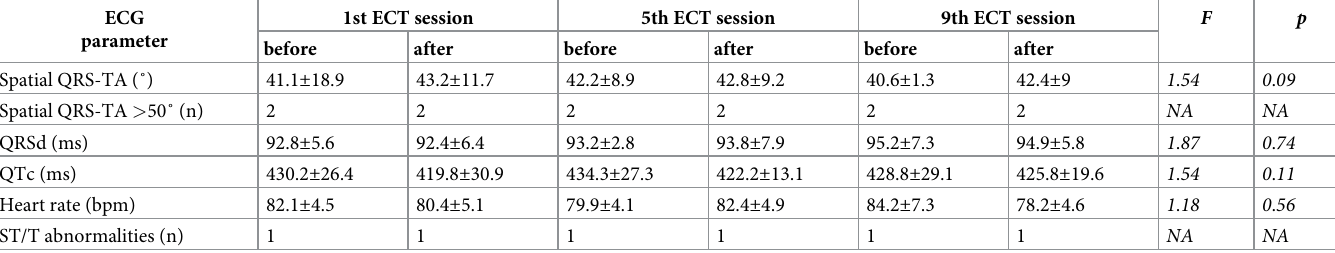
Table 2. The effect of ECT on ECG